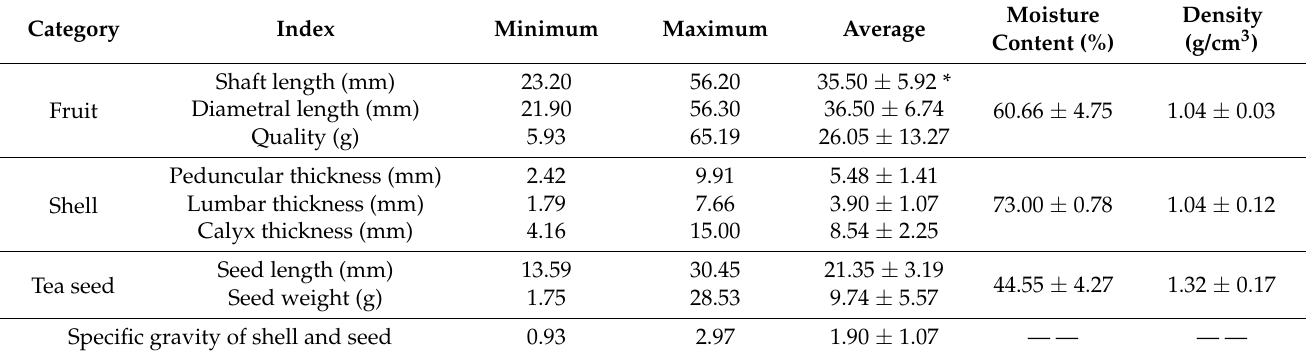
Table 1. Statistical table of parameters of physical characteristics of fresh Camellia oleifera